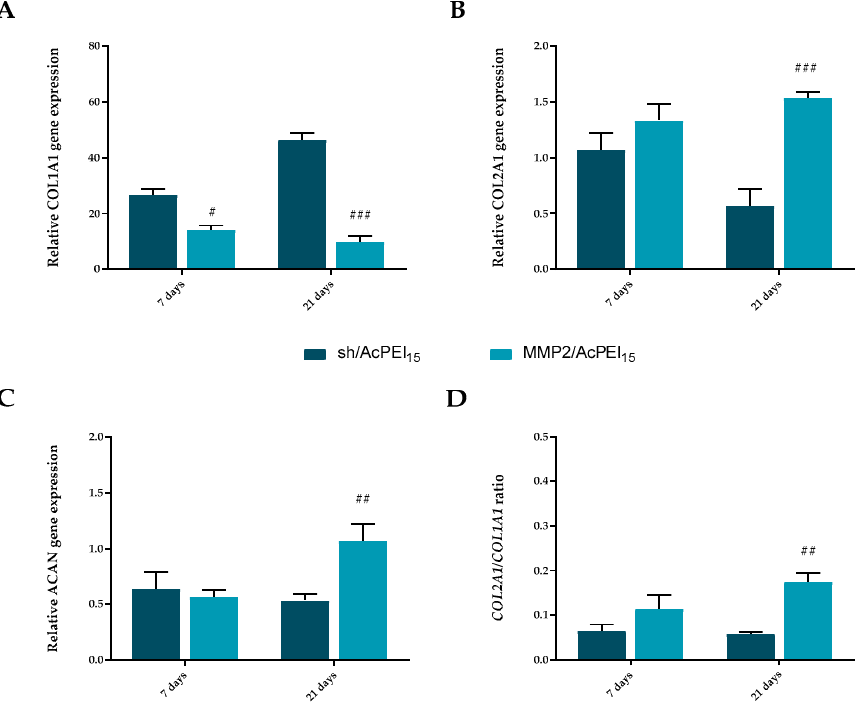
Figure 5. In vitro chondroprotective effect of MMP2/AcPEI 15 . qRT-PCR analysis of ( A ) type I collagen ( COL1A1 ), ( B ) type II collagen ( COL2A1 ) and ( C ) aggrecan ( ACAN ) in embedded chondrocytes cultured, for 7 and 21 days, presence of conditioned medium derived from MMP2/AcPEI 15 -transfected PC3 cells (MMP2/AcPEI 15 ) or conditioned medium from non-transfected cells (sh/AcPEI 15 ). The target gene expression was normalized to the housekeeping genes HPRT1 and GAPDH . Relative differences in the PCR results were calculated using the comparative CT (2 − ∆∆ Ct ) method. The bars represent the means ± standard deviation (n = 3). # p < 0.05, ## p < 0.01 and ### p < 0.001 versus sh/AcPEI 15 . ( D ) The ratios of COL2A1 / COL1A1 of MMP2/AcPEI 15 and of sh/AcPEI 15 cells were calculated as described in Section 2.